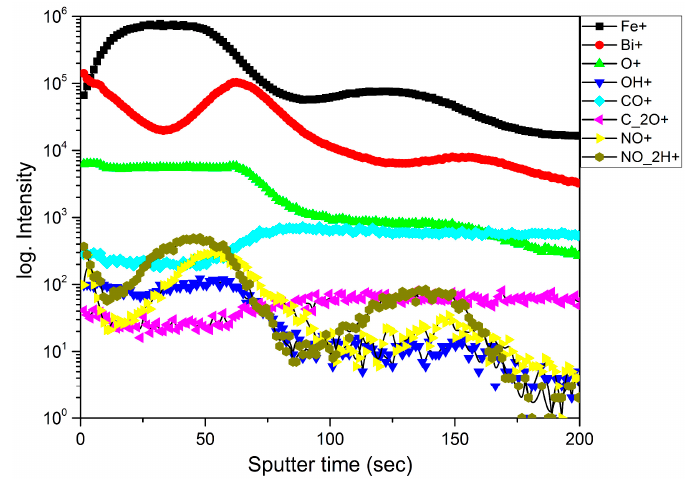
Figure 1. Secondary ion mass spectrometry (SIMS) surface component distribution profile.